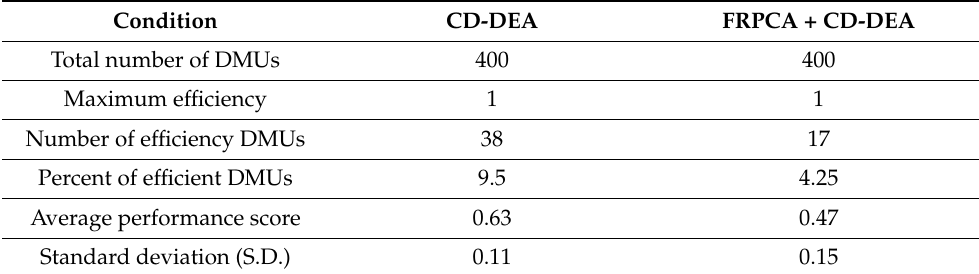
Table 3. The comparison outcomes of two models.